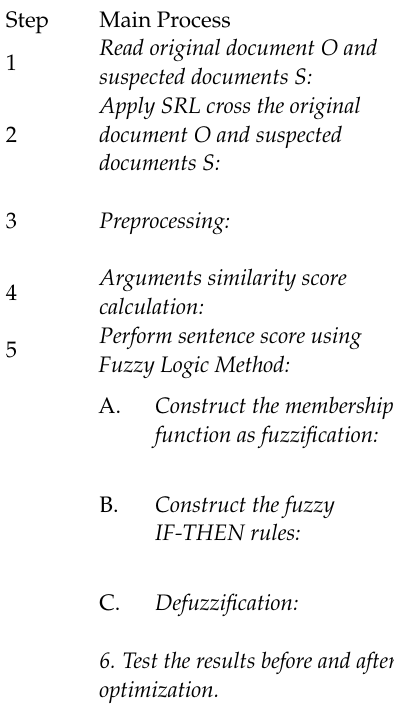
Algorithm 1 An improved plagiarism detection method based on fuzzy logic.